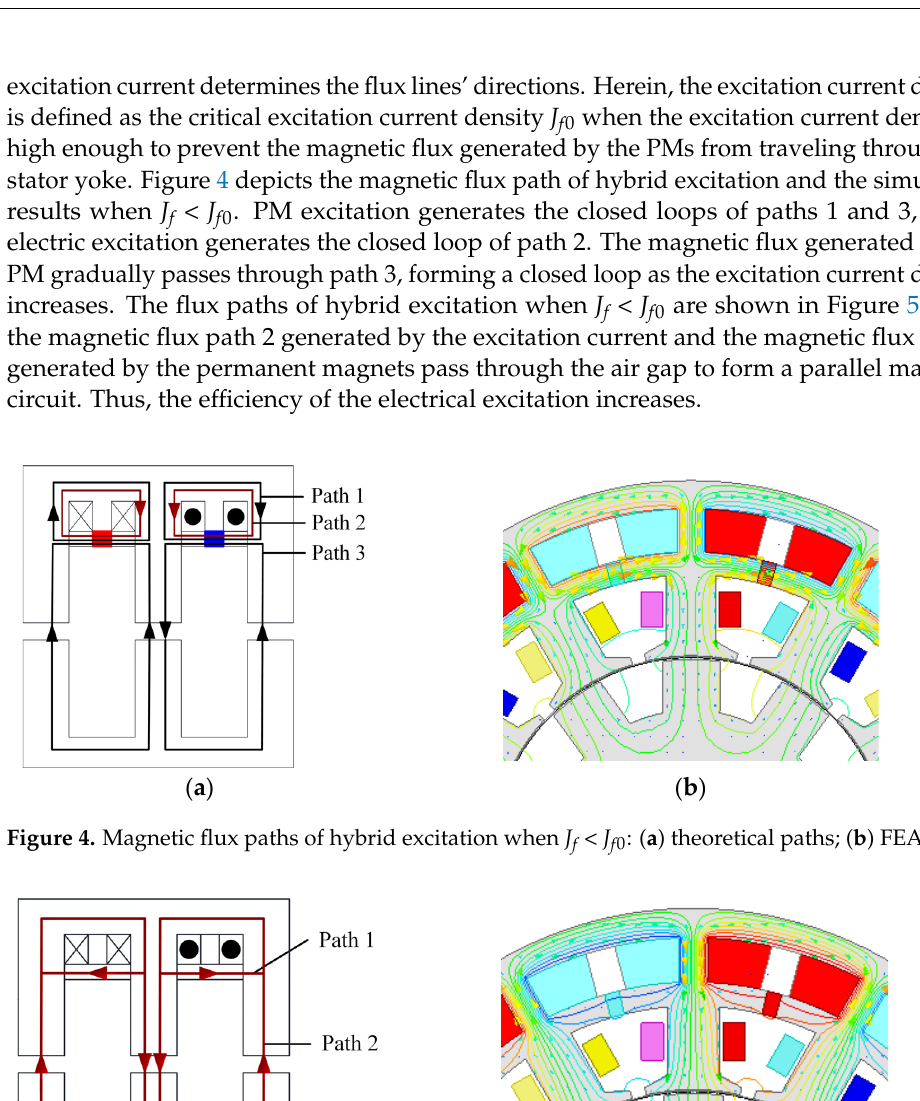
Figure 3. Magnetic flux paths of electric excitation: ( a ) theoretical paths; ( b ) FEA paths.